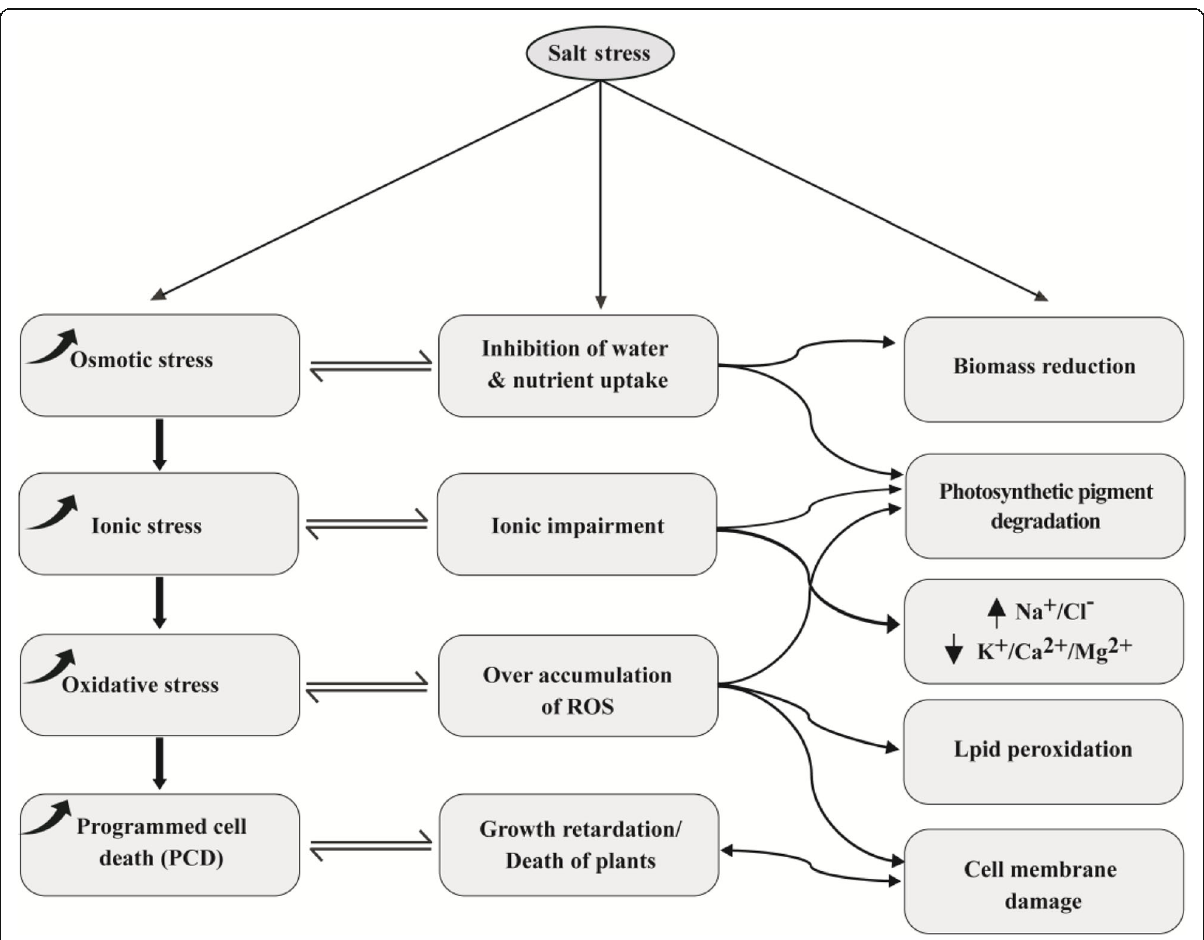
Fig. 6 Schematic summary of salinity mediated physiological